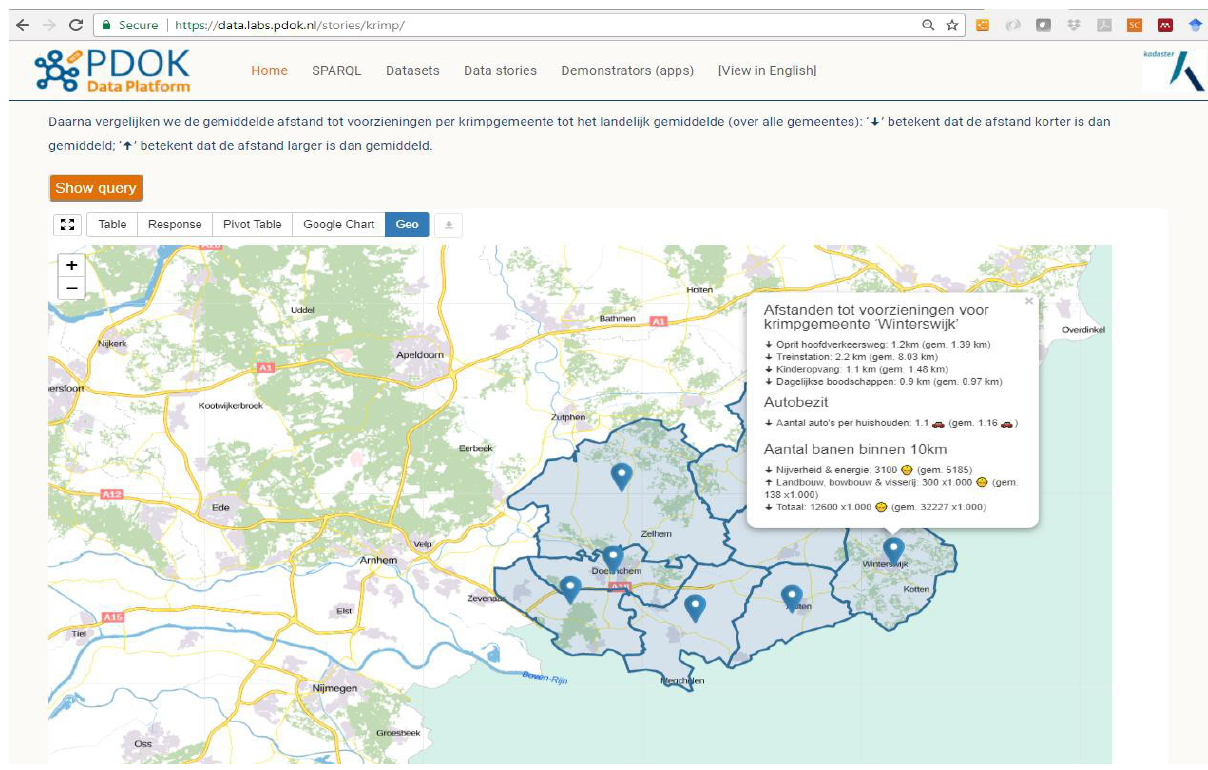
Figure 2. Screenshot from the depopulation Data Story: characteristics of depopulation